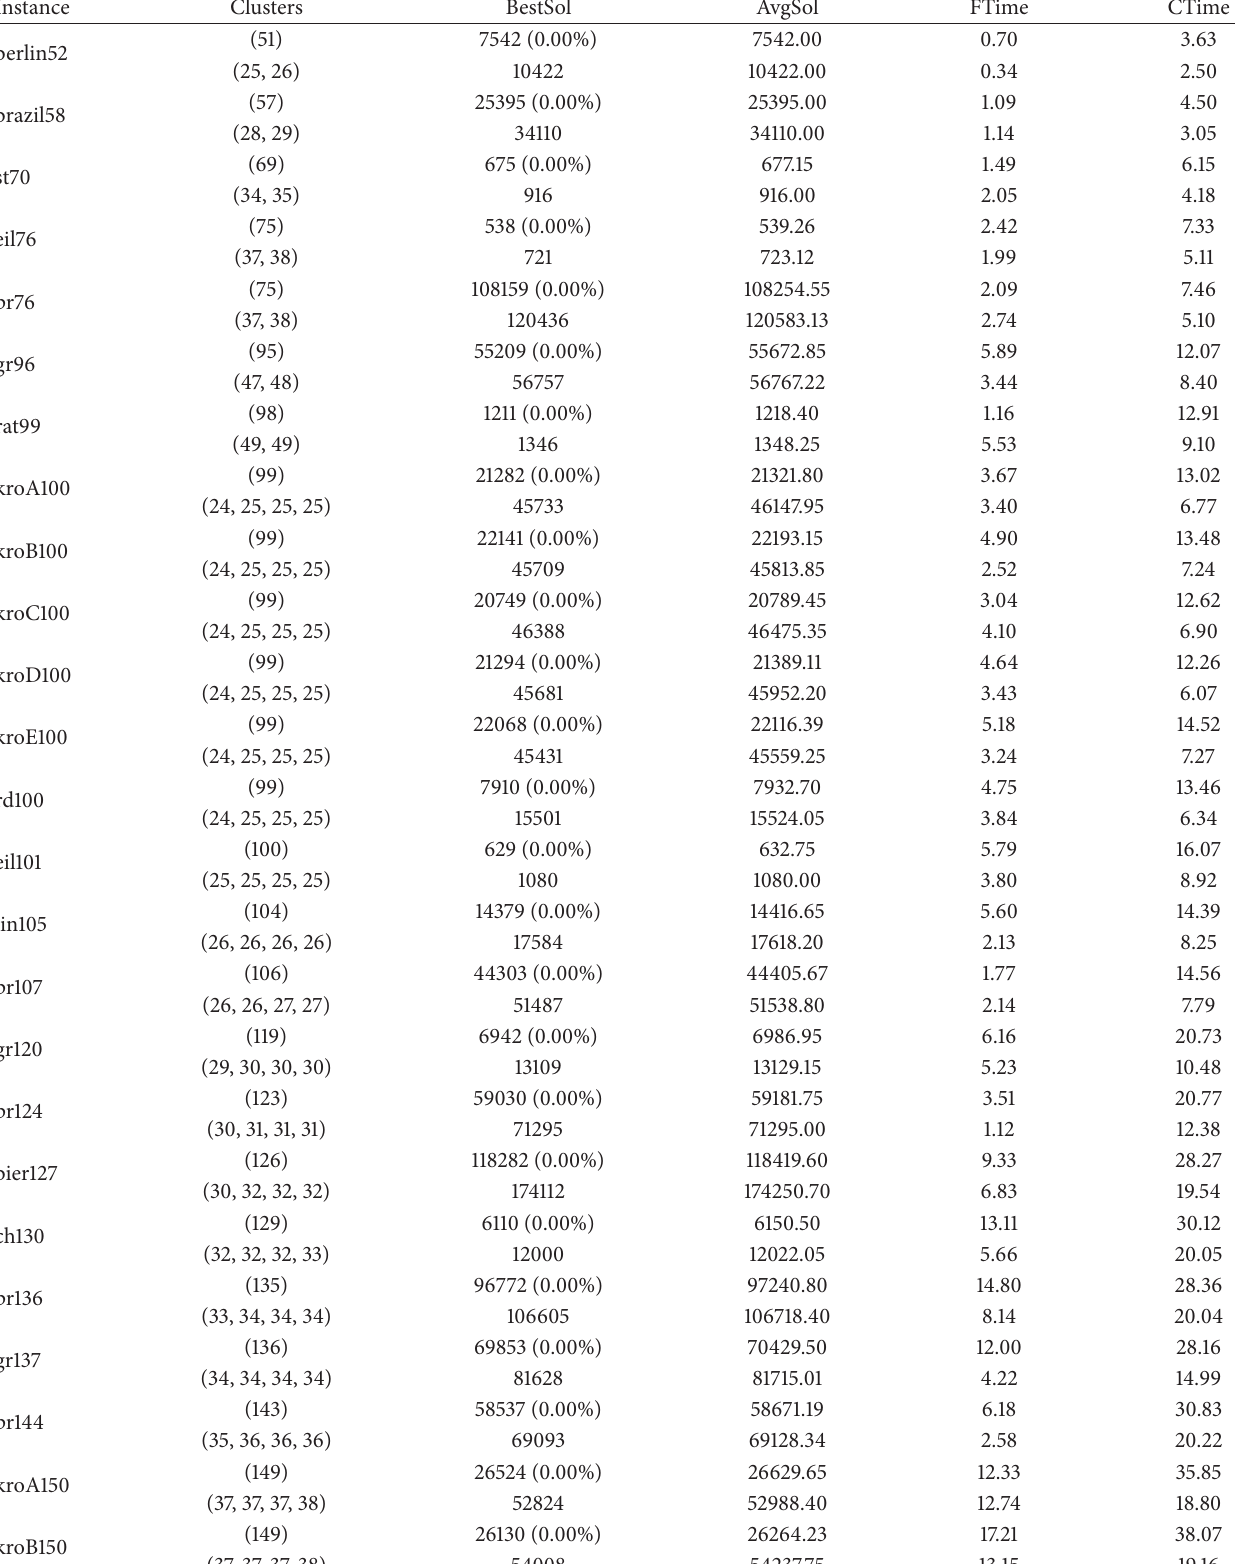
Table 7: Results on some symmetric TSPLIB instances using